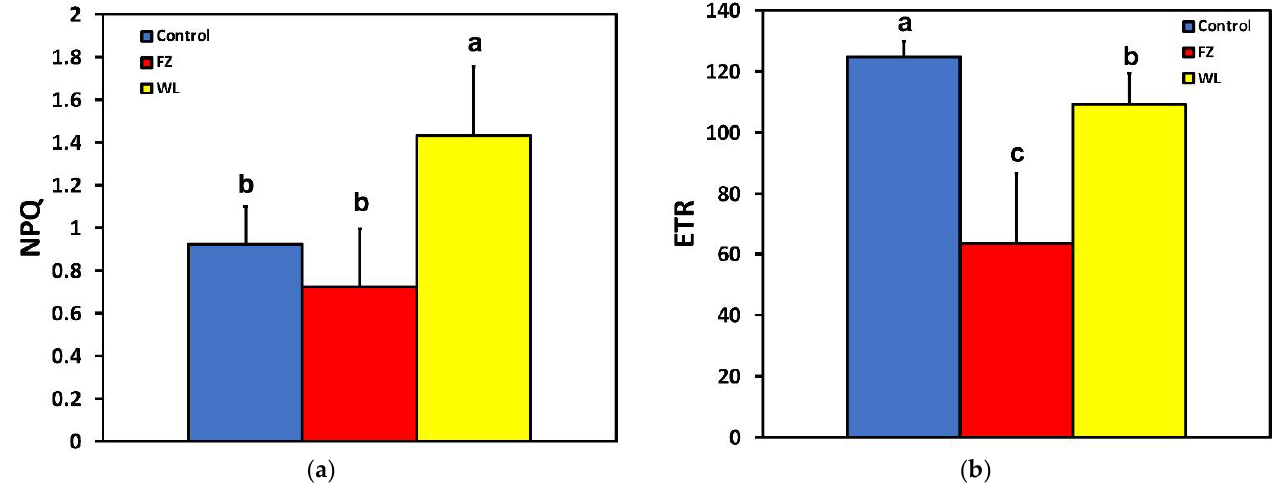
Figure 3. Changes in ( a ) the non-photochemical quenching (NPQ) and ( b ) in the electron transport rate (ETR) at the whole leaflet level before feeding (control), at the feeding zone after feeding (FZ), and at the whole leaflet after feeding (WL). Error bars are standard deviations. Columns with different letters are statistically different ( p < 0.05).